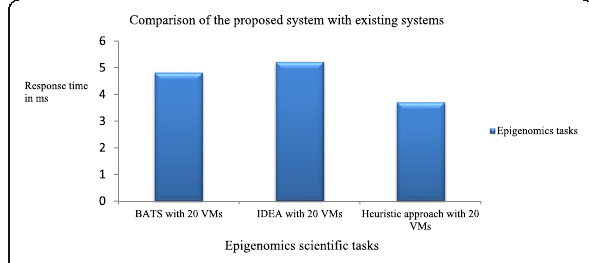
Fig. 9 Response time for epigenomics tasks